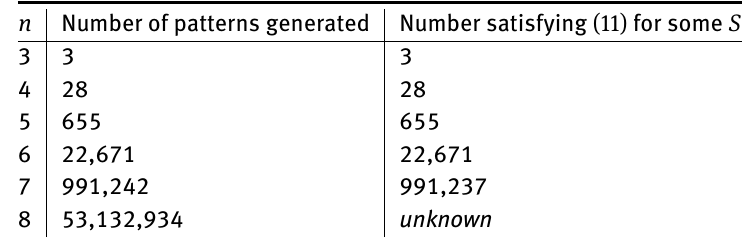
Table 1: Results of exhaustive search of irreducible patterns with 2 n −1 nonzero entries using Algorithm 1. Note that the number of patterns generated is not equal to the number of inequivalent such patterns (see